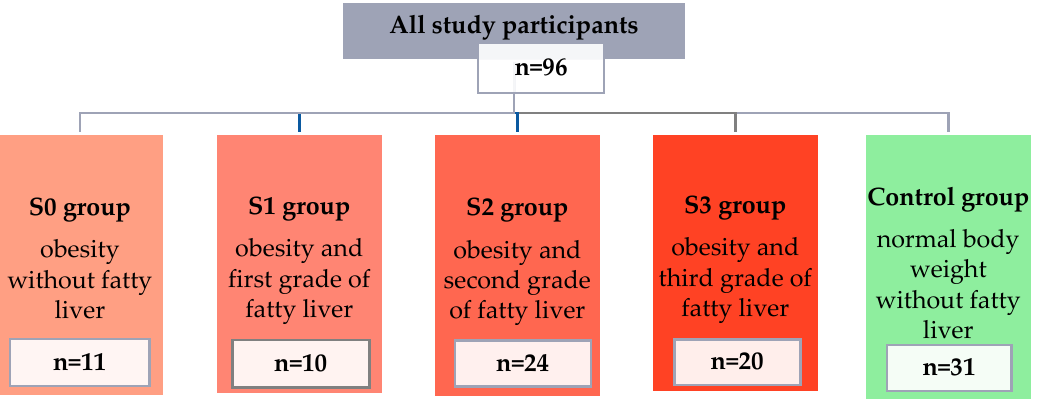
Figure 1. Characteristics of patients qualified for the study, divided into groups.